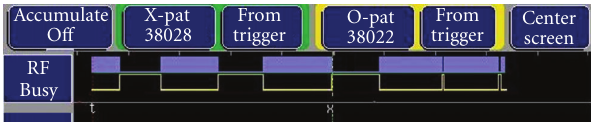
Figure 13: Sensitivity measurement.